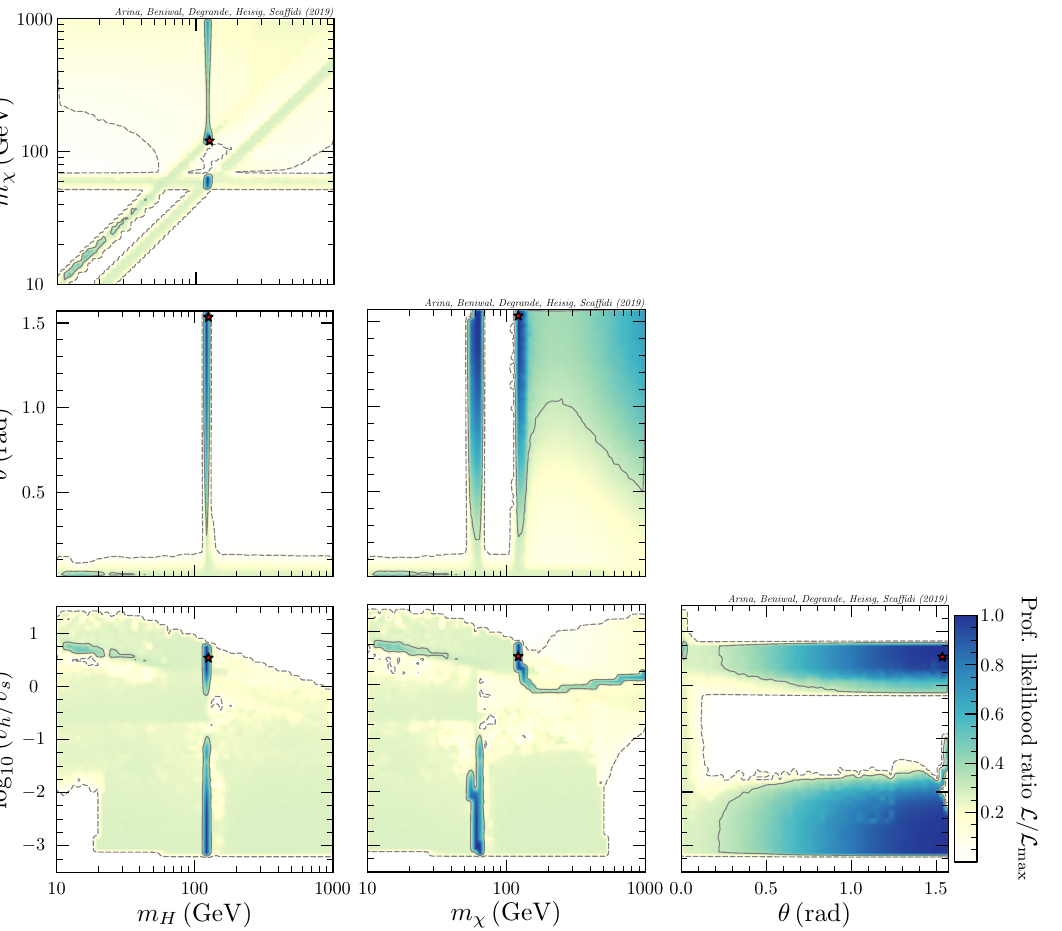
Figure 6 . 2D PLR plots for the pNG DM model parameters after post-processing our MultiNest samples with Fermi -LAT likelihood from 41 dSphs. The best-(cid:12)t point is shown as a red star and summarised in column 2 of table